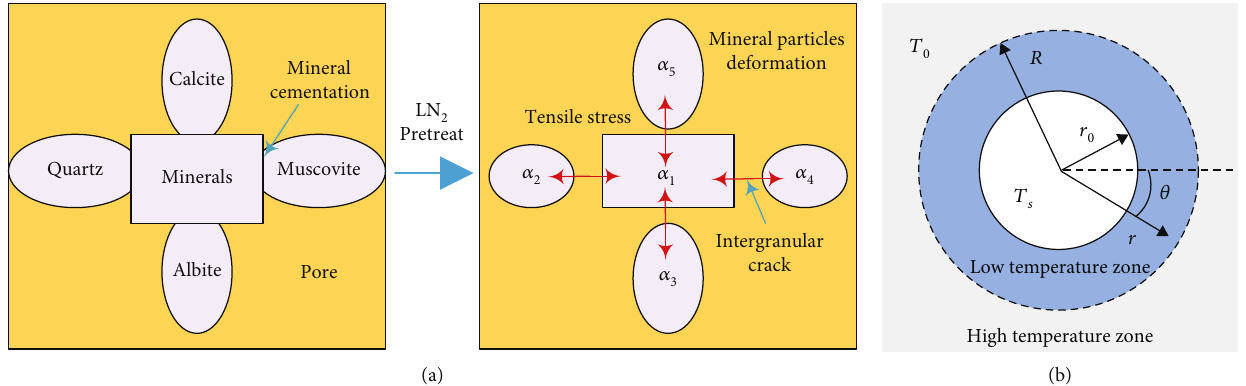
preconditioning. (b) Diagram of temperature fi eld around the borehole 2